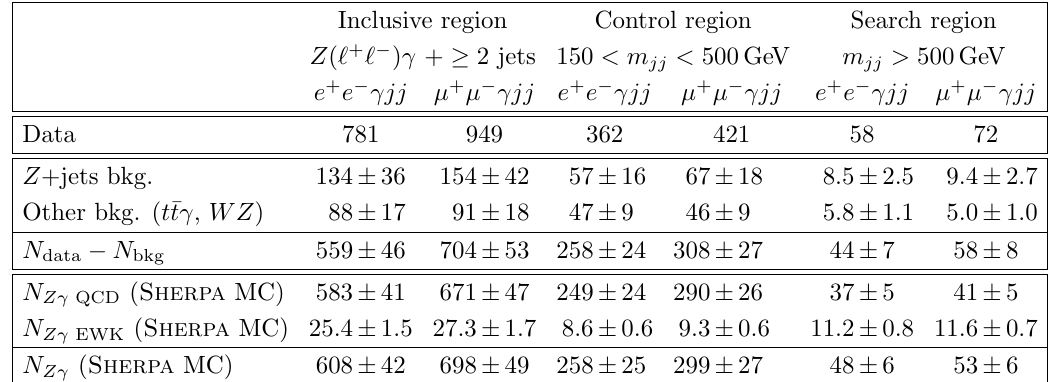
N data (cid:0) N bkg